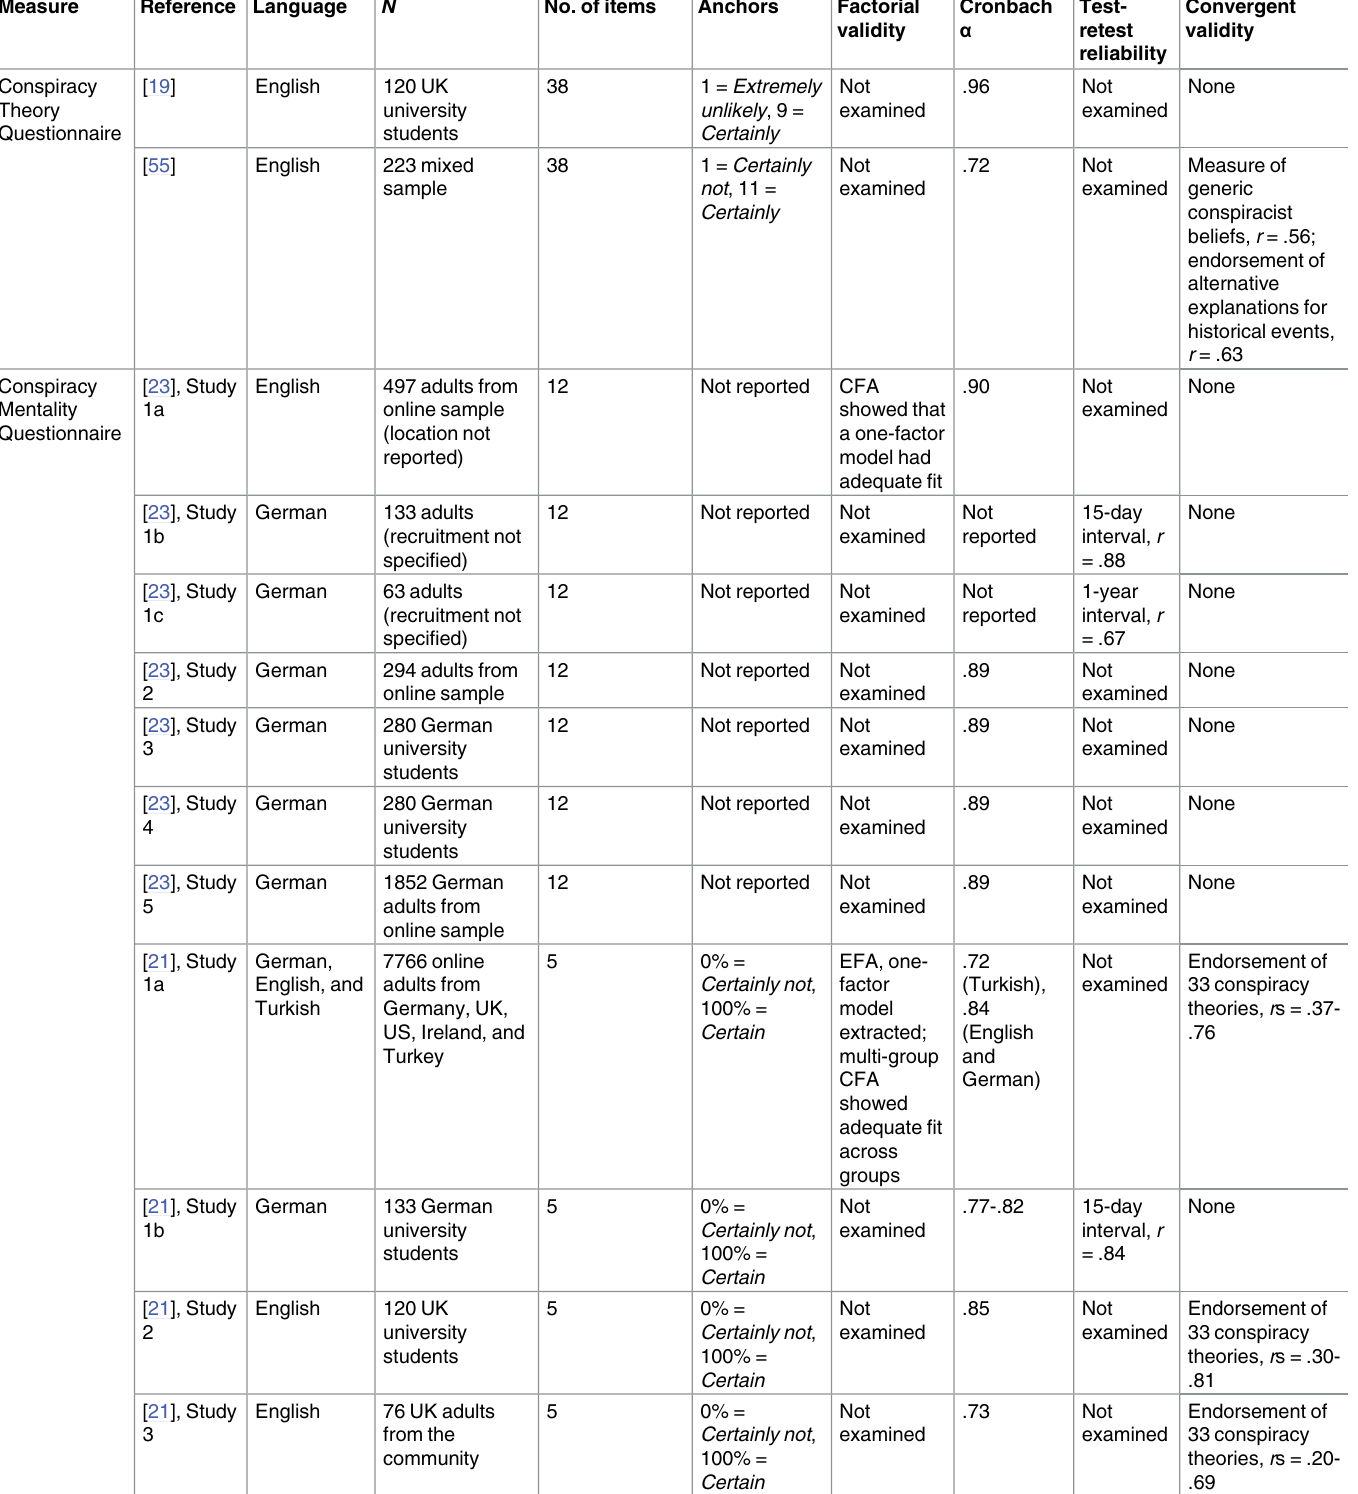
Table 2. Scales that measuregeneric conspiracist